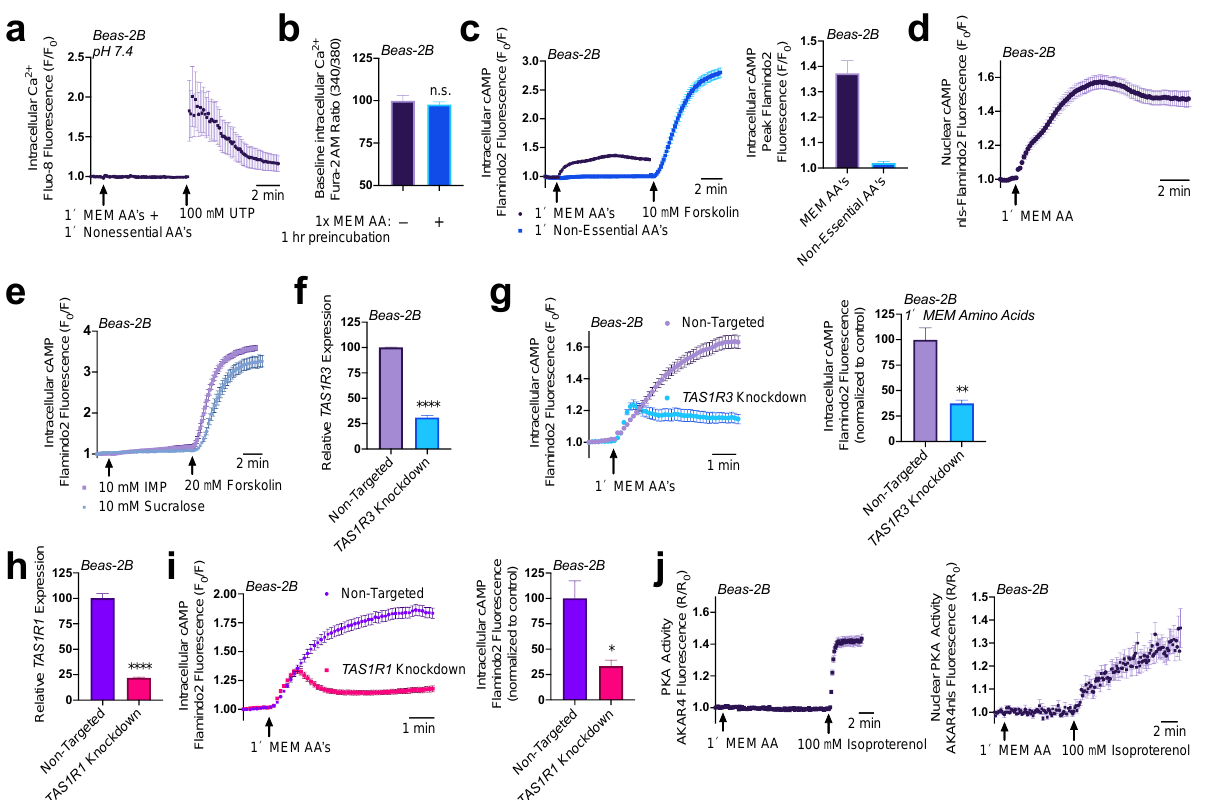
Figure 2. Amino acids and lactisole activate cAMP. ( a ) A pH-corrected mixture of MEM amino acids (AAs) and nonessential amino acids does not induce intracellular Ca 2+ release in Beas-2Bs. ( b ) 1× MEM amino acids do not alter baseline intracellular Ca 2+ levels as detected via ratiometric Ca 2+ dye Fura-2. ( c ) Beas-2Bs expressing cAMP biosensor Flamindo2 reveal that 1× MEM amino acids but not 1× non-essential amino acids alter intracellular cAMP levels. ( d ) 1× MEM AAs also elevate nuclear cAMP levels as measured in Beas-2Bs expressing the Flamindo2 biosensor containing a nuclear lo- calization (nls) sequence. ( e ) Neither T1R2/3 agonist sucralose nor T1R1/3 agonist inosine mono- phosphate (IMP) alter intracellular cAMP. ( f ) RNAi duplexes targeting TAS1R3 transcript reduce expression by 70% relative to non-targeting scramble controls. ( g ) Knocking down T1R3 impaired detection of MEM amino acids by 70% relative to non-targeting controls. ( h ) RNAi duplexes target- ing TAS1R1 transcript reduce expression by 75% relative to non-targeting controls. ( i ) Knocking down T1R1 leads to a 75% reduction in cAMP signaling in response to MEM amino acids relative to non-targeting controls. ( j ) 1× MEM AAs do not increase either intracellular or nuclear PKA activ- ity within the sensitivity range of the AKAR4 biosensor. Traces are representative of ≥3 experiments. Bar graphs show mean ± SEM from ≥3 experiments. Significance determined by t -test * p < 0.05, ** p < 0.01, **** p < 0.0001, “ n.s. ” represents no significance.